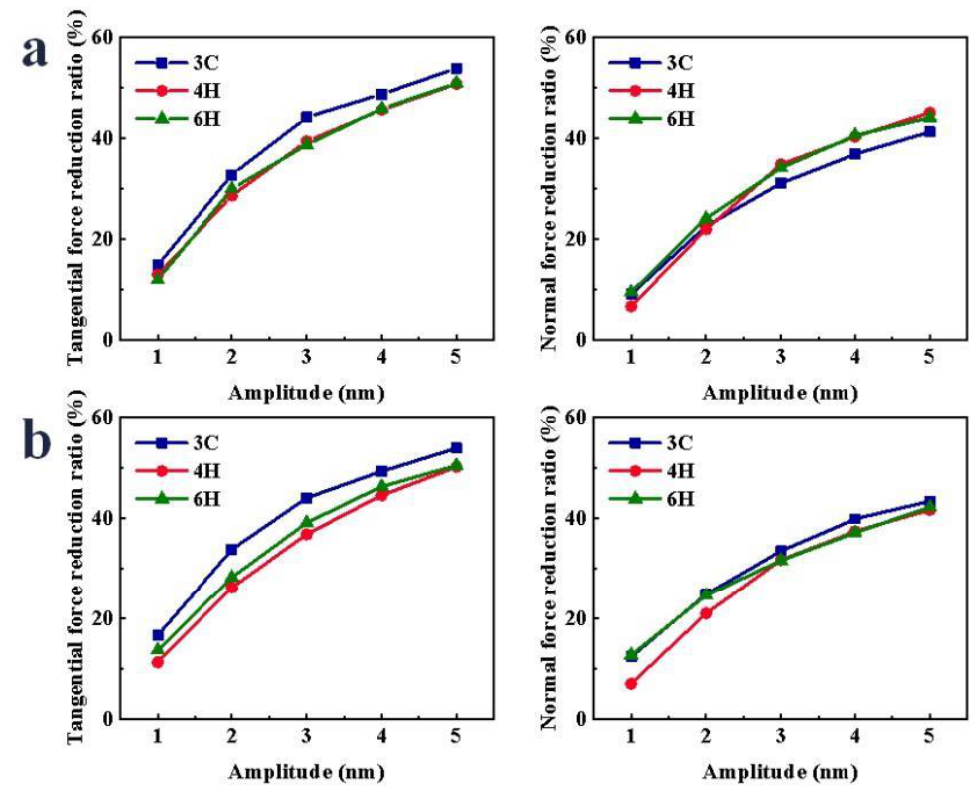
Figure 3. Variation in scratch force reduction ratio of SiC polytypes with different amplitudes: ( a ) Si-face and ( b ) C-face of SiC.